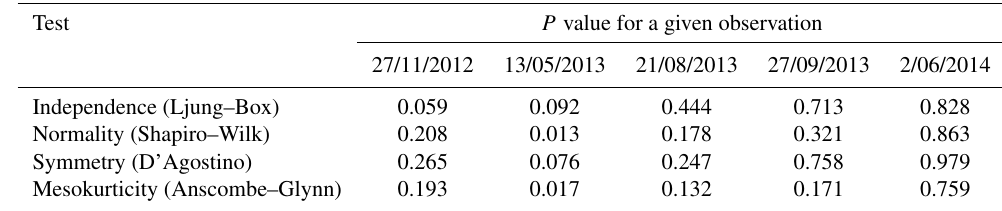
P value for a given observation